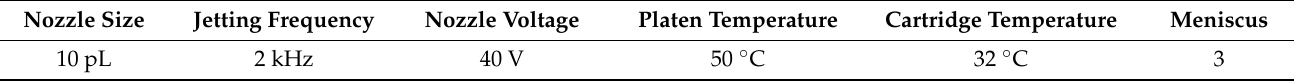
Table 6. Additional inkjet printing parameters to print PVA. Nozzle Size Jetting